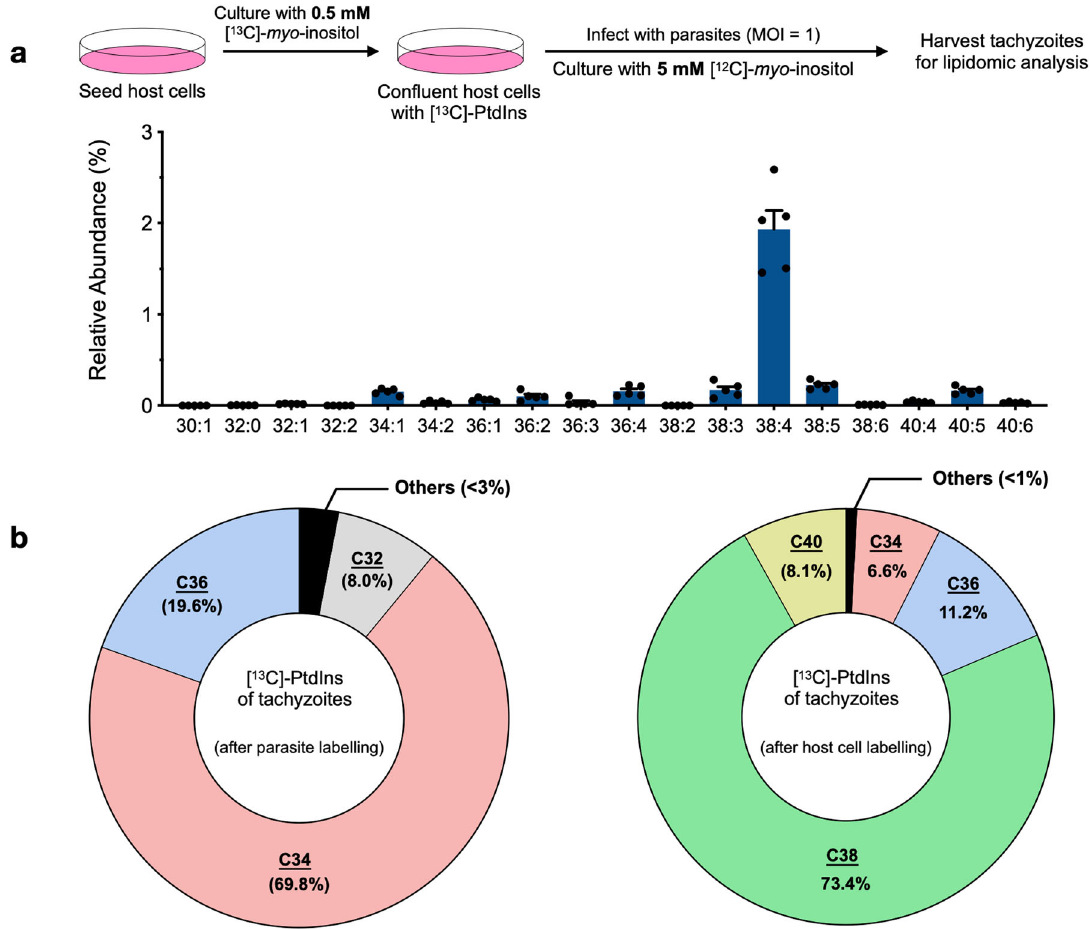
Fig. 8 Tachyzoites can synthesize as well as salvage selected PtdIns species from host cells. a HFF labeling with [ 13 C]- myo -inositol and intracellular propagation of tachyzoites in prelabeled host cells to test the salvage of [ 13 C]-PtdIns. Brie fl y, host cells were grown to con fl uence in the presence of 0.5 mM [ 13 C]- myo -inositol, and then infected with tachyzoites of the PIS mutant (MOI = 1) in the presence of 5 mM myo -inositol to minimize the import and usage of residual intracellular isotope by the parasite ’ s de novo synthesis. Puri fi ed extracellular tachyzoites were examined by lipidomic analysis. Note that this assay was technically (intricate data normalization) not feasible with the auxin-treated Tg PIS mutant due to a need of higher MOI for initial infection (and thus more unlabeled PtdIns), and much slower growth in the presence of IAA (and thus prolonged incubation). The data plotted are from 5 independent assays (mean ± S.E.). b Proportion of [ 13 C]-PtdIns species detected after stable isotope labeling of extracellular tachyzoites (left, see Fig. 4e), and in tachyzoites after propagation in prelabelled host cells (right, see a ). Only primarily-labeled PtdIns species ( ≥ 1%) are named; the minor-labeled species are shown as “ Others ”